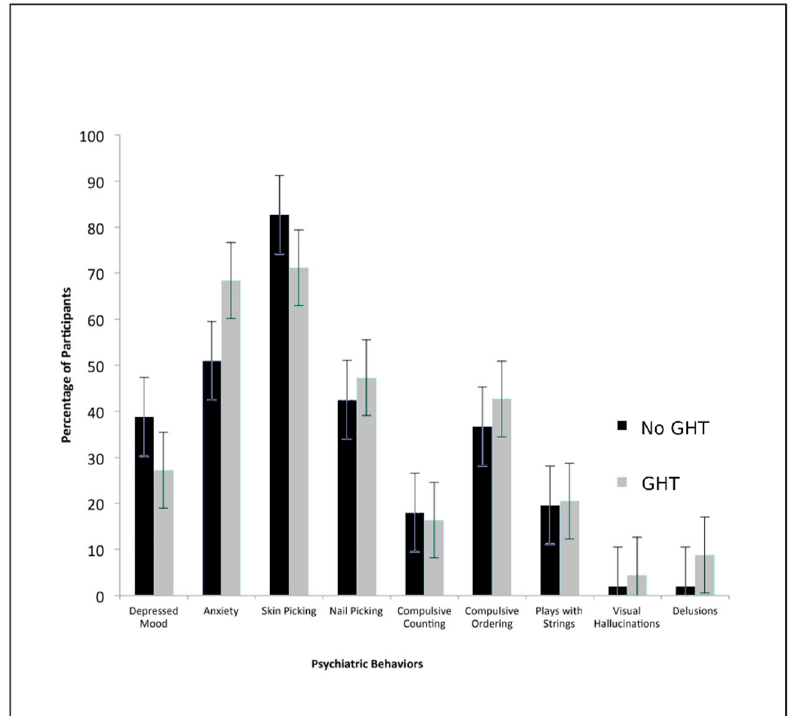
Figure 1. Association between psychiatric behavior and growth hormone treatment use. Percentage of GHT users and non-GHT users who reported the presence of each psychiatric behavior (unadjusted for confounders) at their first visit. There was a significantly higher prevalence of anxiety in GHT users over non-GHT users ( p = 0.03).